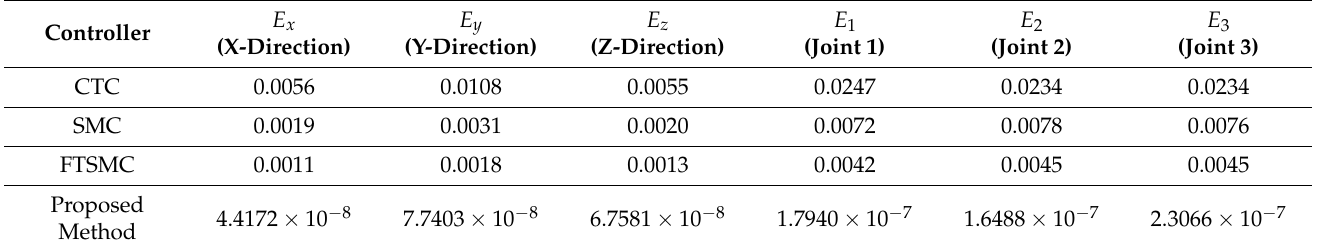
Table 5. RMSEs of four controllers in the second